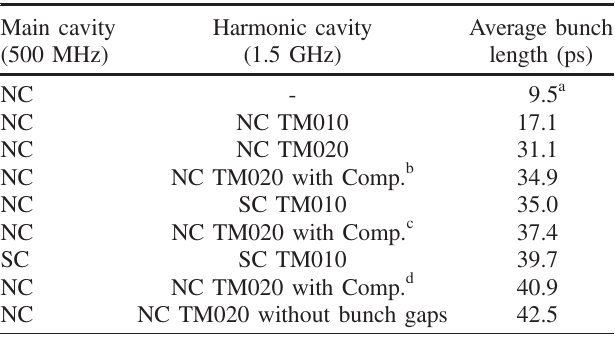
TABLE V. Summary of the average rms bunch lengths that were estimated with semianalytical calculations. We assumed a beam current of 500 mA, two bunch trains, 60-ns bunch gaps, and the KEK-LS